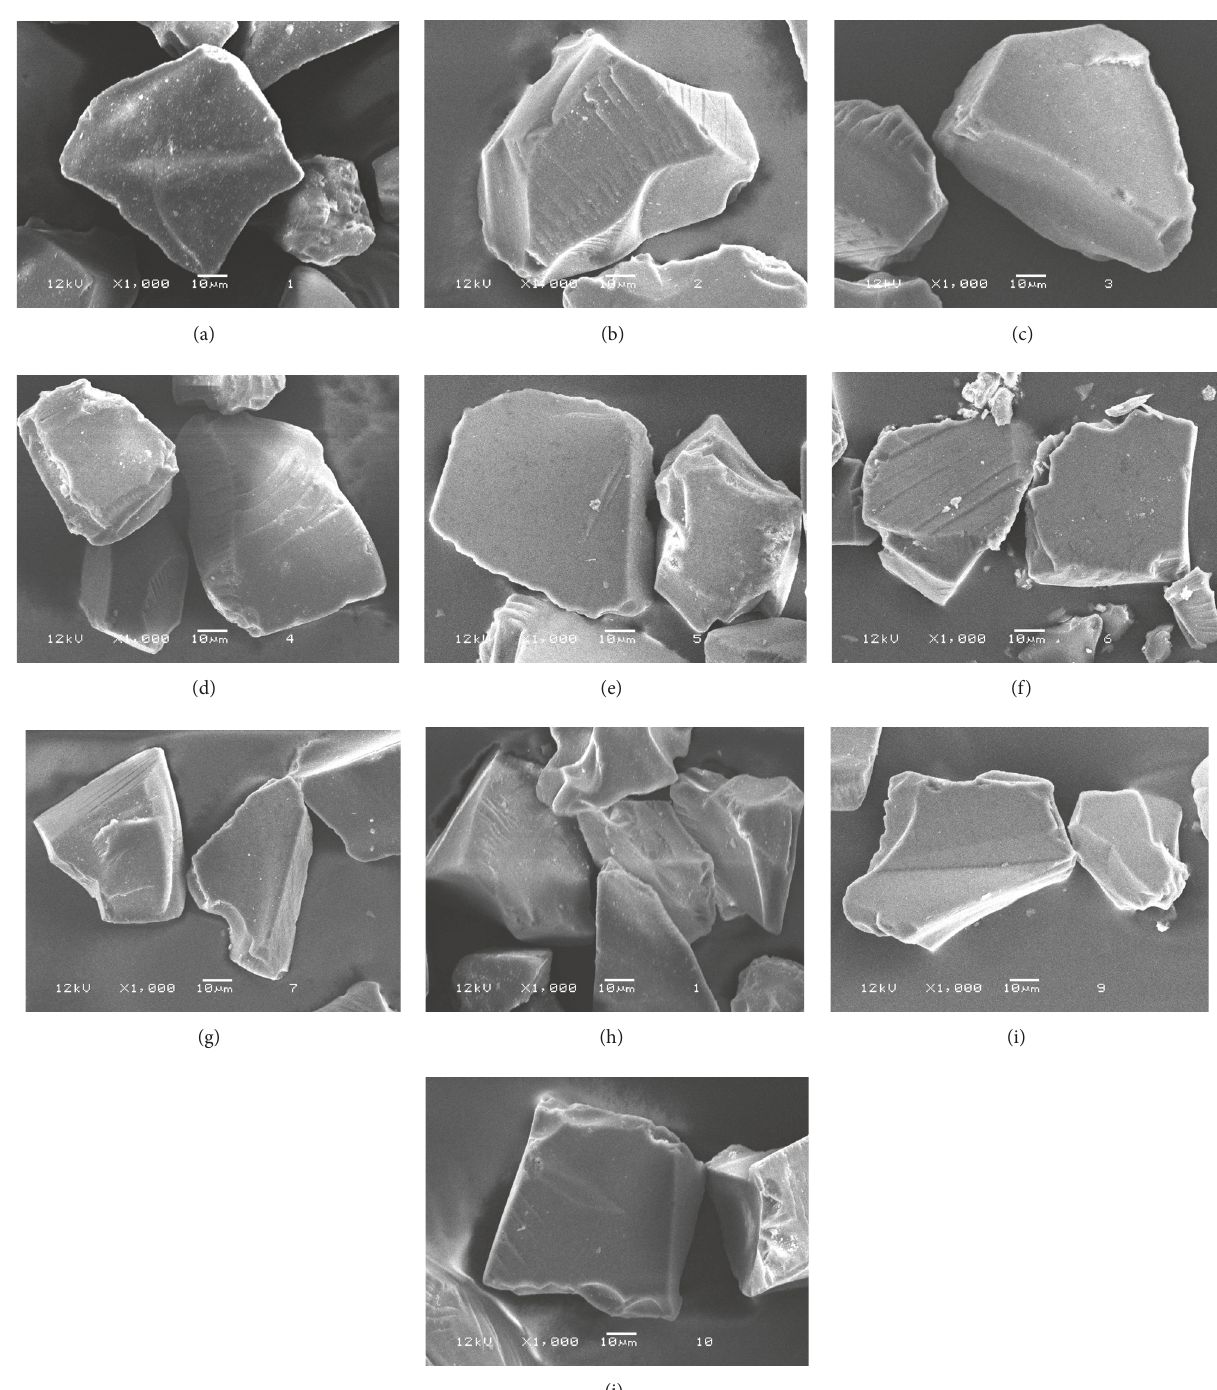
Figure 3: SEM image of (a) SiO 2 , (b) SiO 2 @ imineSA, (c) SiO 2 @ imineSA-Pd-II, (d) SiO 2 @ imineSB, (e) SiO 2 @ imineSB-Pd-II, and (f) SiO 2 @ imineSA-Pd-I, (g) SiO 2 @ imineNA, (h) SiO 2 @ imineNA-Pd-II, (i) SiO 2 @ imineNB, and (j) SiO 2 @